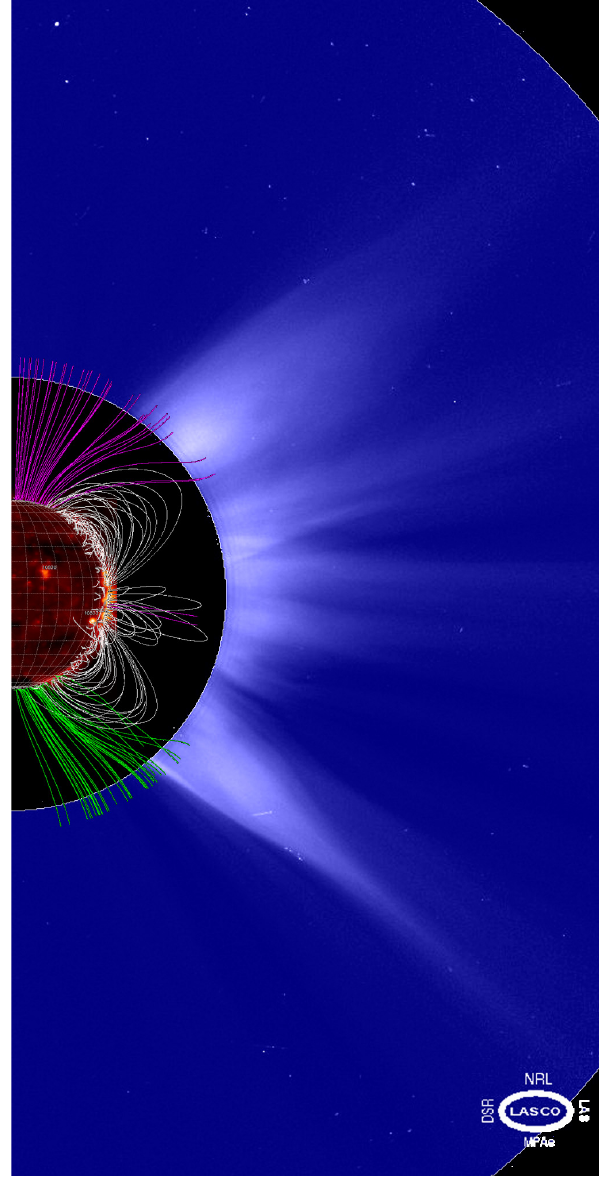
Fig. 1. The white light solar corona (west limb) as seen by the SOHO/LASCO C2 coronagraph before the CME (10 December 13:00UT) and a soft X-ray image of the solar disk made by the GOES/SXI instrument (10 December 12:58UT). Superposed open (green and purple) and closed (white) fieldlines have been com- puted with a PFSS extrapolation (see text) from Carrington rotation map